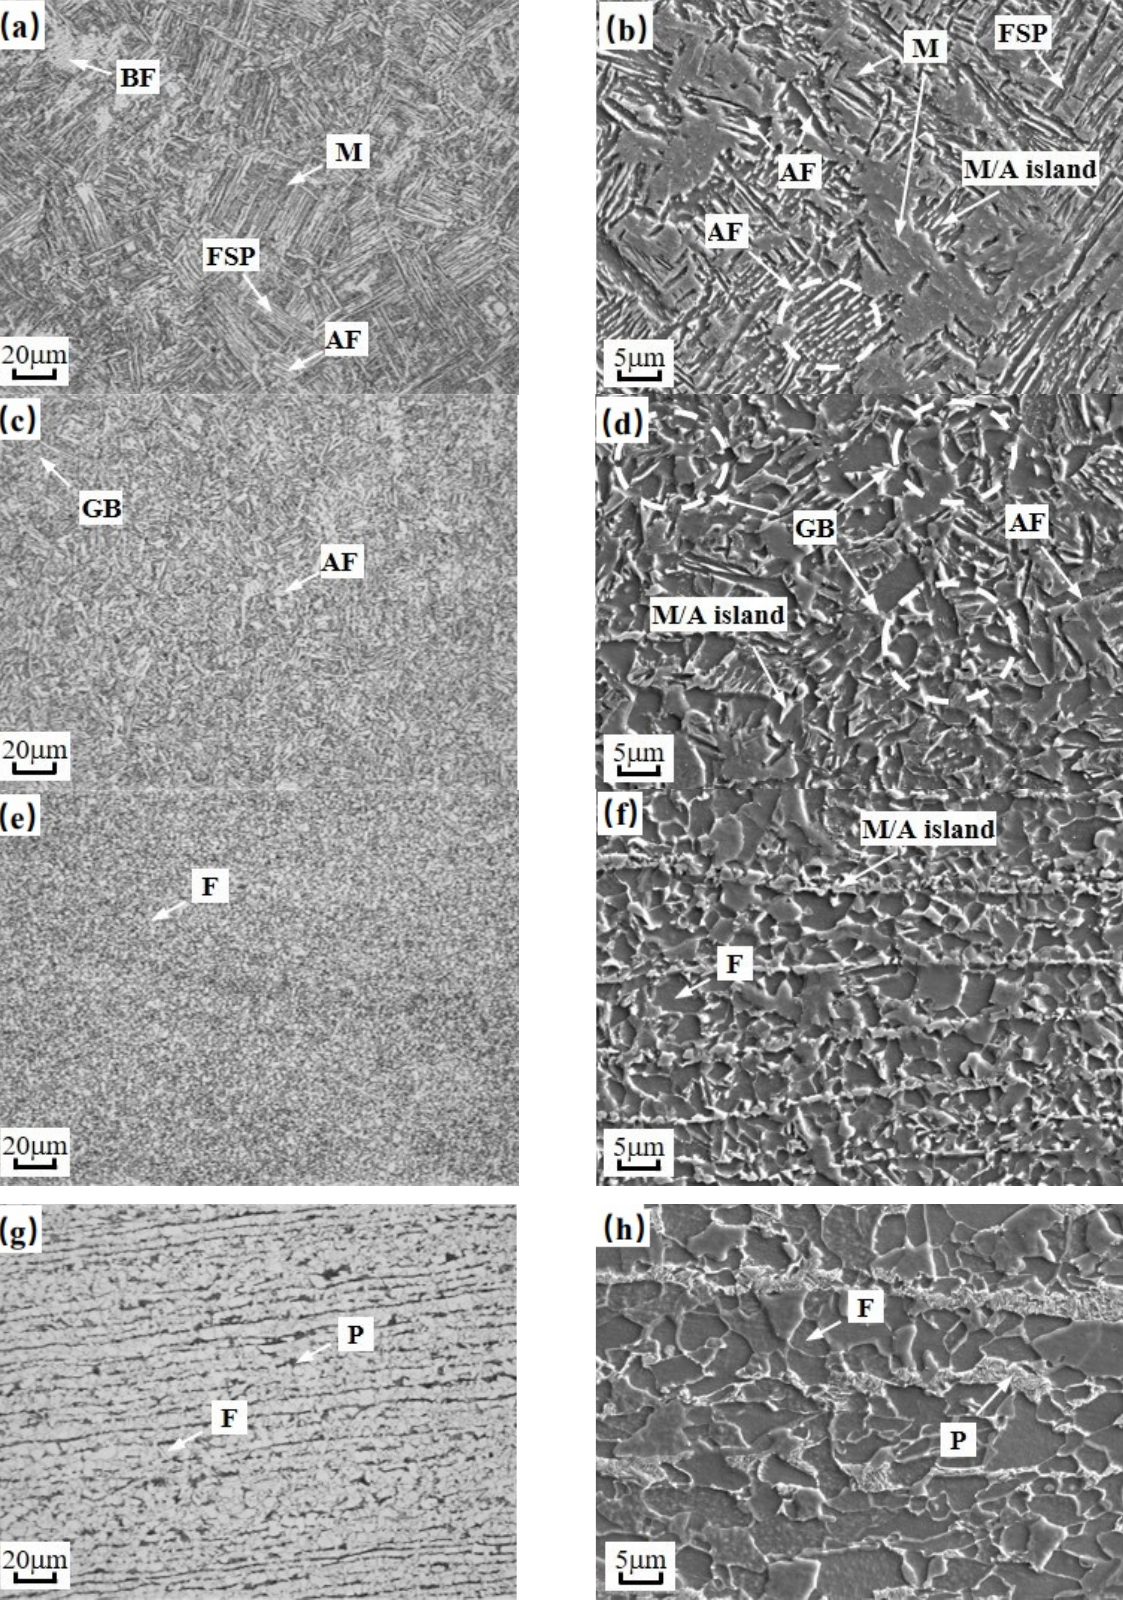
Figure 4. OM micrographs and SEM micrographs of different regions of the welded joint. ( a , b ) WS;